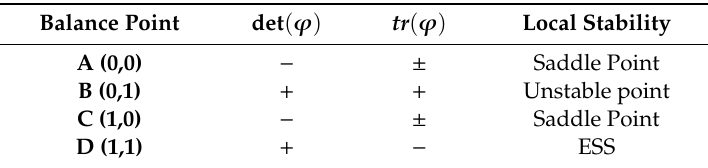
Table 5. Stability analysis of Case 3.